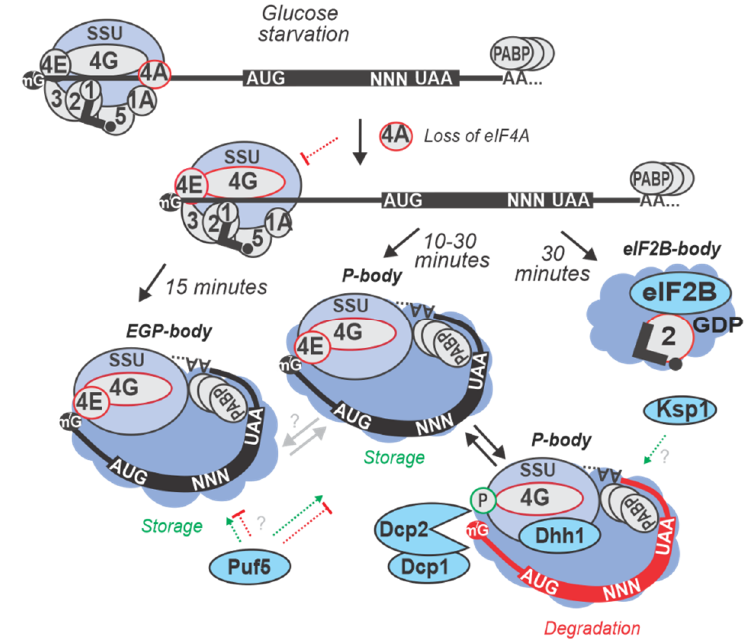
Figure 4. Re-localization of mRNA and translation factors into cytoplasmic foci during acute response to glucose starvation. Glucose starvation of 10 min in yeast results in the loss of eIF4A from the scanning complexes, which may stimulate utilization of other helicases, such as Ded1p or Dhh1p. EGP-bodies (SGs) are first formed at about 15 min of starvation, where the mRNA and the initiation factors are stored. Upon 30 min of glucose starvation, P-bodies (where mRNA can also be selectively degraded, such as due to phosphorylation of eIF4G by Ksp1p and recruitment of helicases like Dhh1p to glycolytic mRNAs) and eIF2B-bodies form. Regulatory RBPs, such as Puf5p, may mRNA-selectively promote storage or degradation decisions. Color coding as in Figure